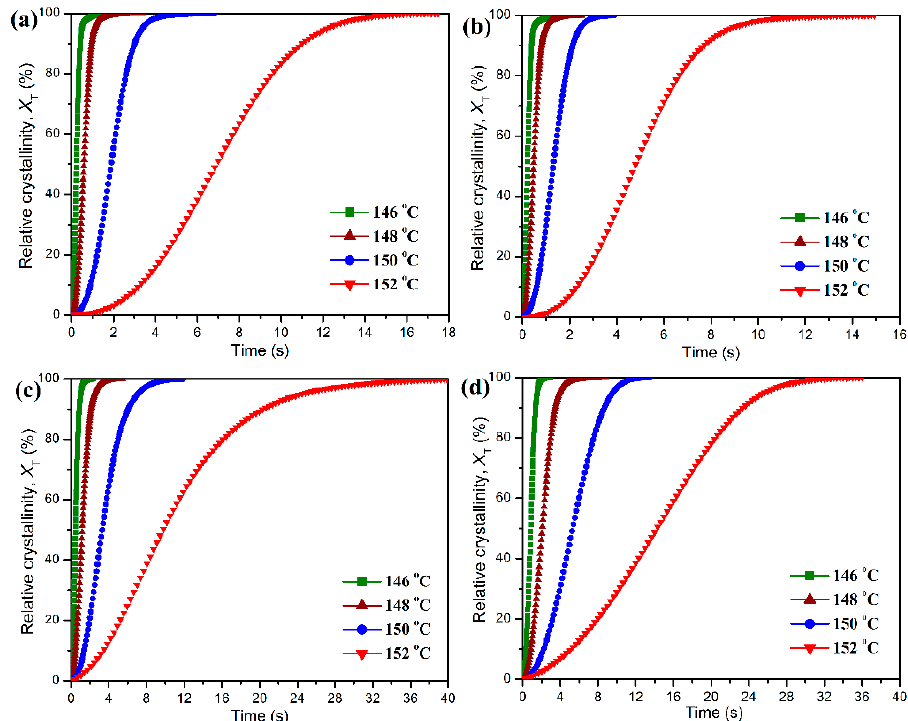
Figure 10. Development of relative degree of crystallinity as a function of time for the isothermal crystallization of ( a ) pure POM and its blends with ( b ) 10 wt %, ( c ) 20 wt %, and ( d ) 40 wt % of PLA at different crystallization temperatures.